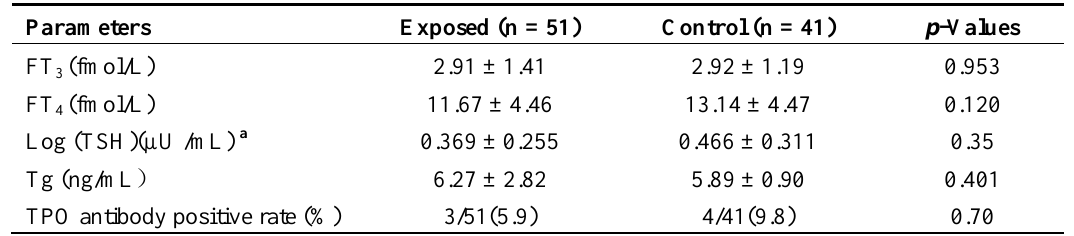
Table 6. Statistical description of the thyroid function indicators of workers from the exposed group and control group (Mean ±